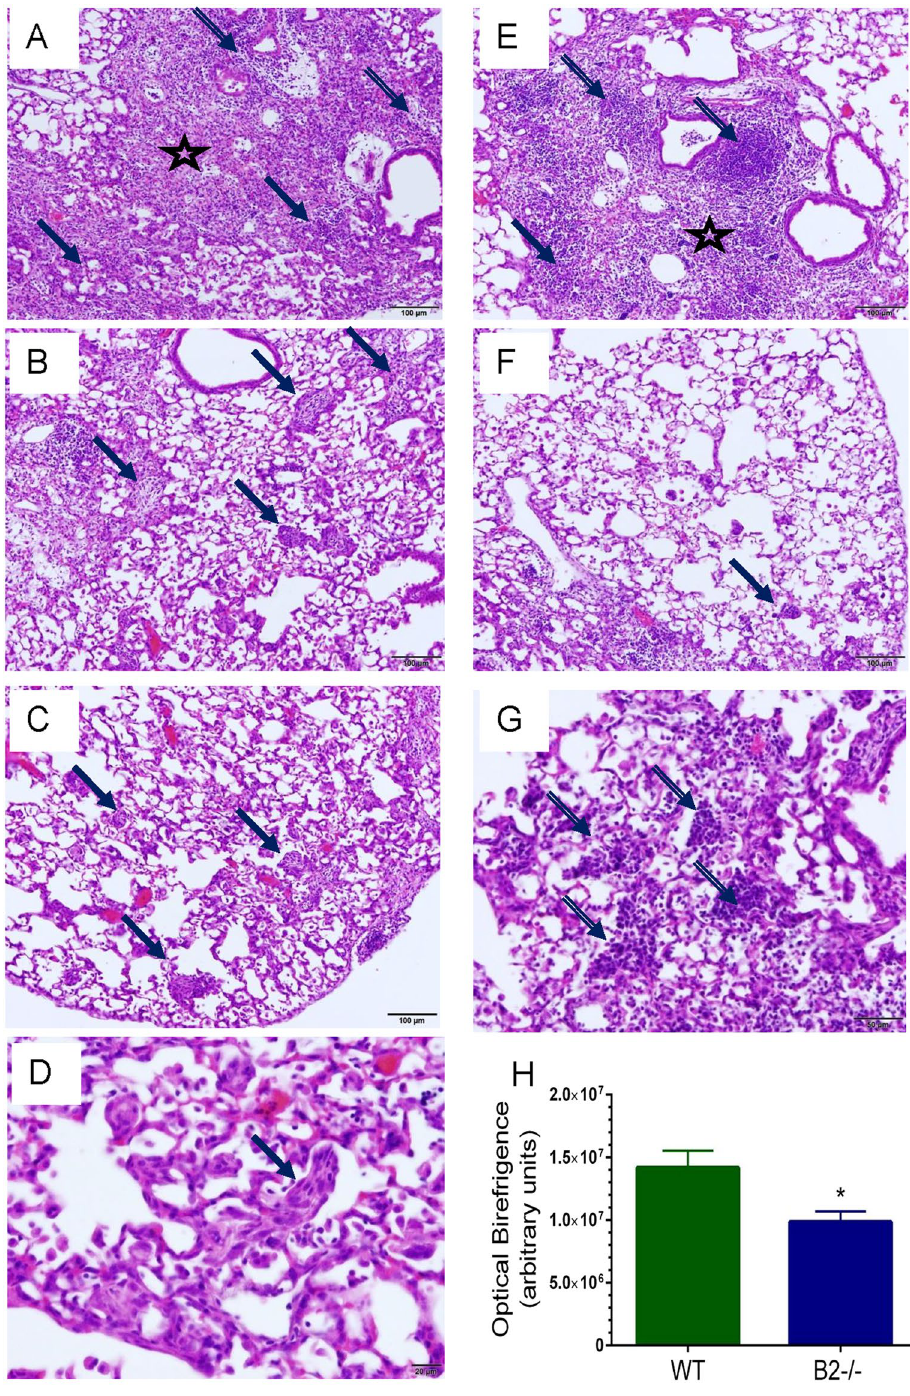
Figure 4. Different histopathological features in WT and B2 − / − lungs after clearance of IAV infection. Histopathology was assessed 14 days after infection from two independent experiments. Images shown are representative of n = 7 WT mice and n = 5 B2 − / − mice. ( A ) Fibrotic lesions (star) with areas of metaplasia (solid arrows) and disperse mononuclear infiltrates (lined arrows) consolidate the peribronchial and alveolar spaces of WT mice. ( B–D ) Cryprogenic organizing pneumonia with buds of granulation tissue in alveoli of WT mice (solid arrows). ( E ) Fibrotic lesions (star) with areas of metaplasia (solid arrow) and lymphocytic foci (lined arrows) consolidate the peribronchial and alveolar spaces of B2 − / − mice. ( F ) Mild (solid arrow) to absent cryptogenic organizing pneumonia in B2 alveoli. ( G ) Alveolar lymphocytic infiltrates in B2 − / − lungs. Magnification for A, B, C, E, and F: 100x; D: 600 x; G: 400x. ( H ) Comparison of collagen birefringence in WT and B2 − / − lungs. Collagen was visualized picric sirius red stain. * p < 0.00046. Data shown are means ± SEM from total of 50 and 60 microscopic fields at 200x magnification in lung sections from n = 4 WT mice and n = 5 B2 − / − mice,